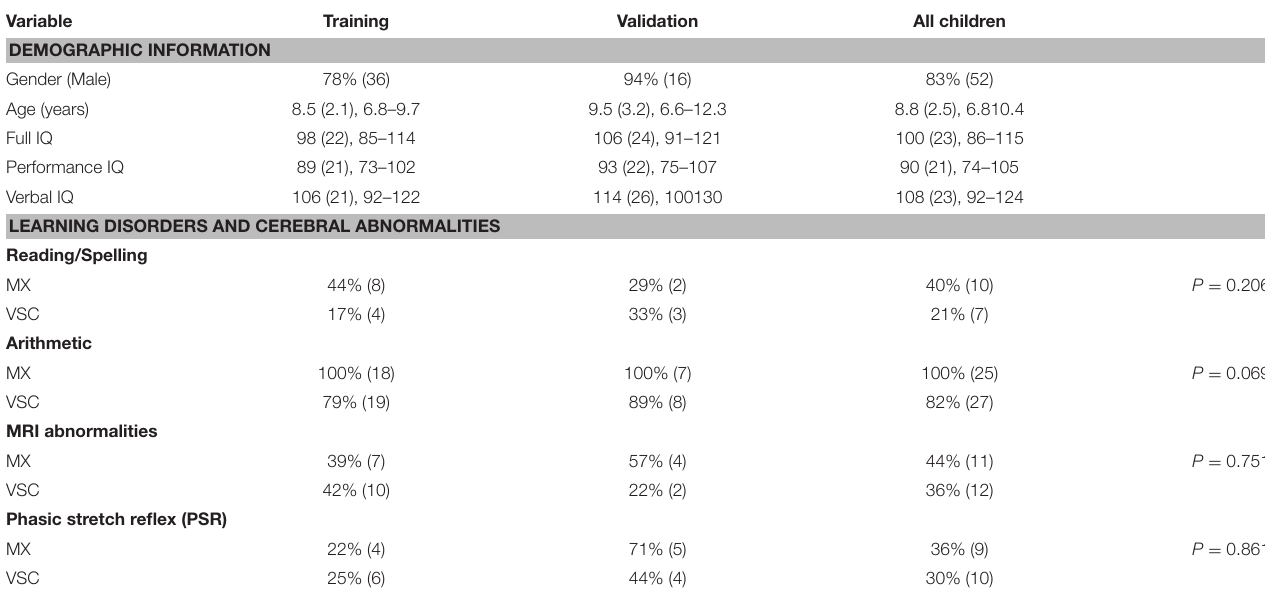
TABLE 3 | Children’s